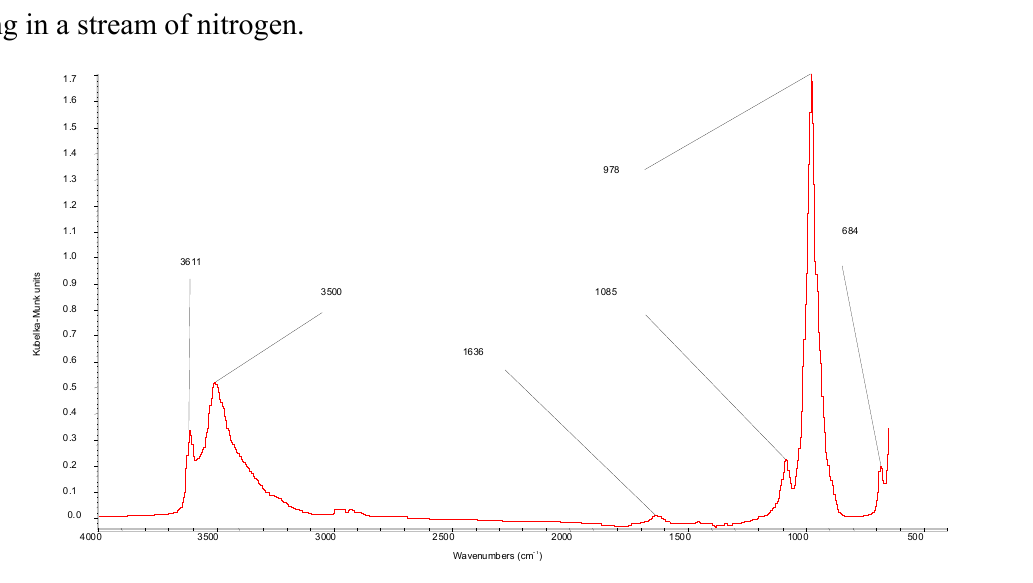
Table 1. DRIFTS and XRD analysis for Atmospheric Dried (AD) slurry. DRIFTS wavenumbers in cm − 1 XRD spacing in Å (relative intensity) Reference Compounds